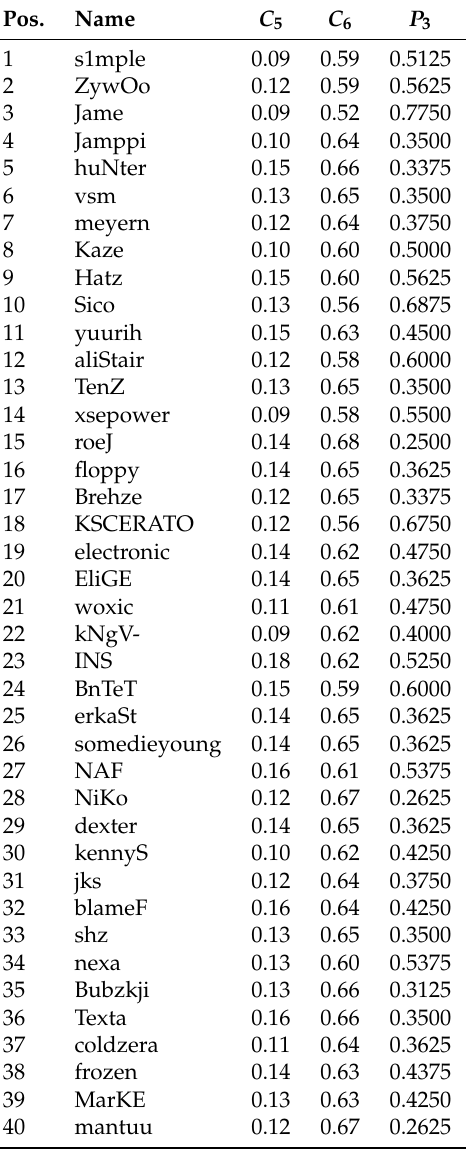
Table A2. The performance table of the selected criteria C 5 , C 6 and assessment model P 3 .